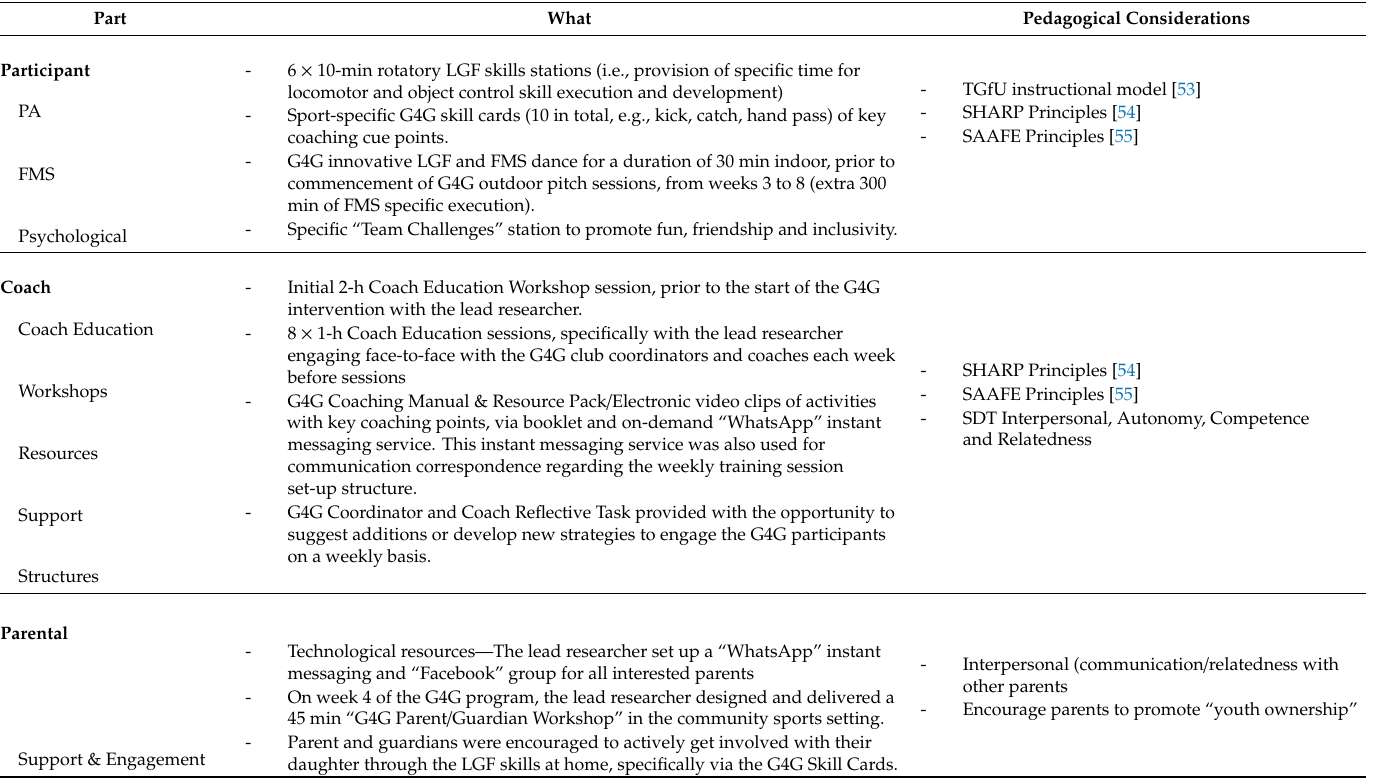
Abbreviations: PA = physical activity; FMS = fundamental movement skills; G4G = Gaelic4Girls; TGfU = Teaching Games for Understanding; SHARP = “Stretching whilst moving”, “High repetition of motor skills”, “Accessibility through di ff erentiation”, “Reducing sitting and standing”, “Promoting on pitch physical activity”; SAAFE = “Supportive, Active, Autonomous, Fair, and